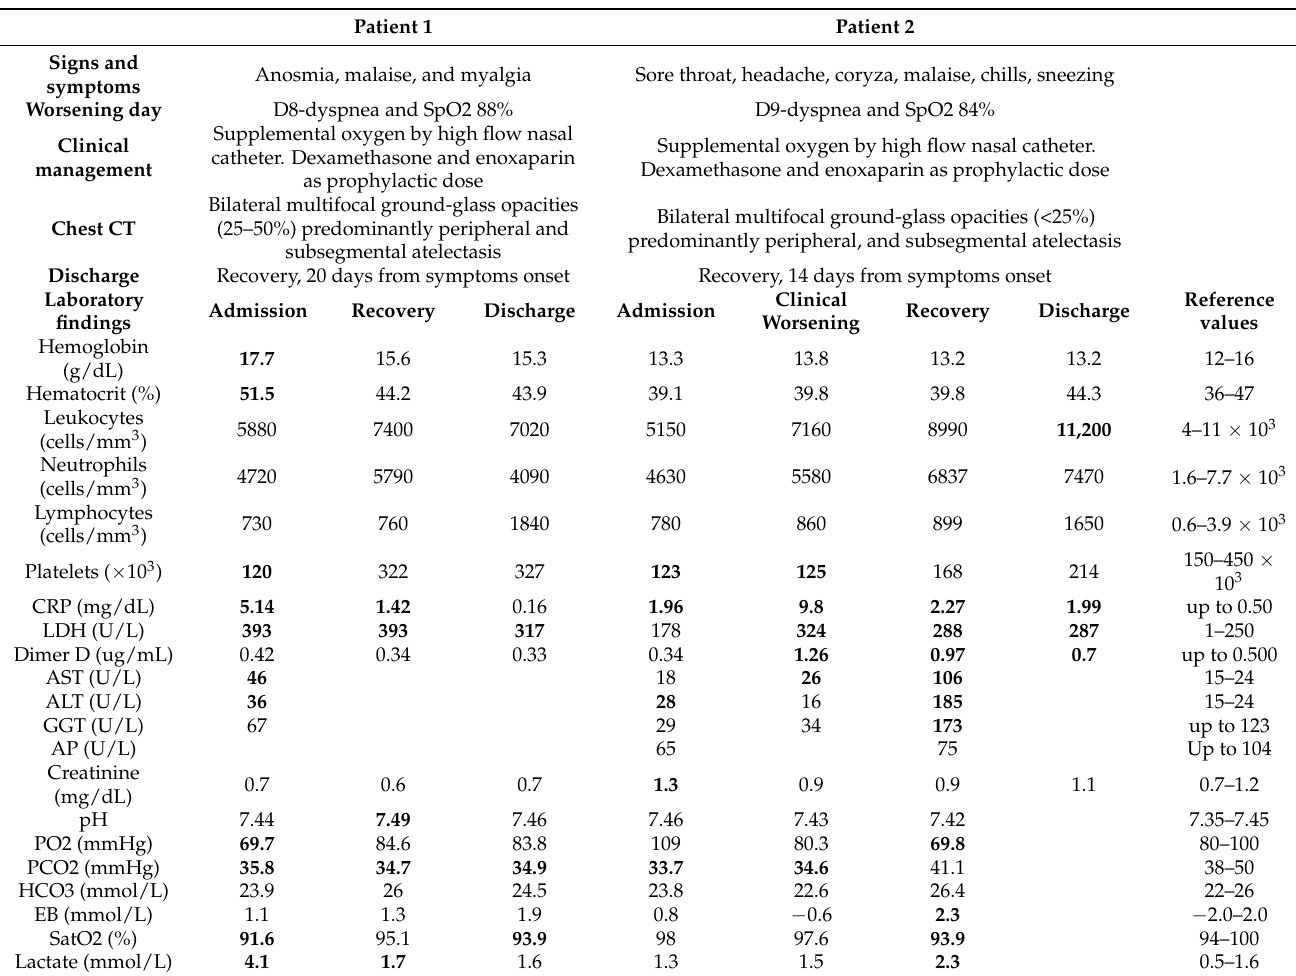
Table 1. Clinical and laboratory findings during the progressing of COVID-19 in two patients vaccinated with CoronaVac. In bold: out of range results from reference